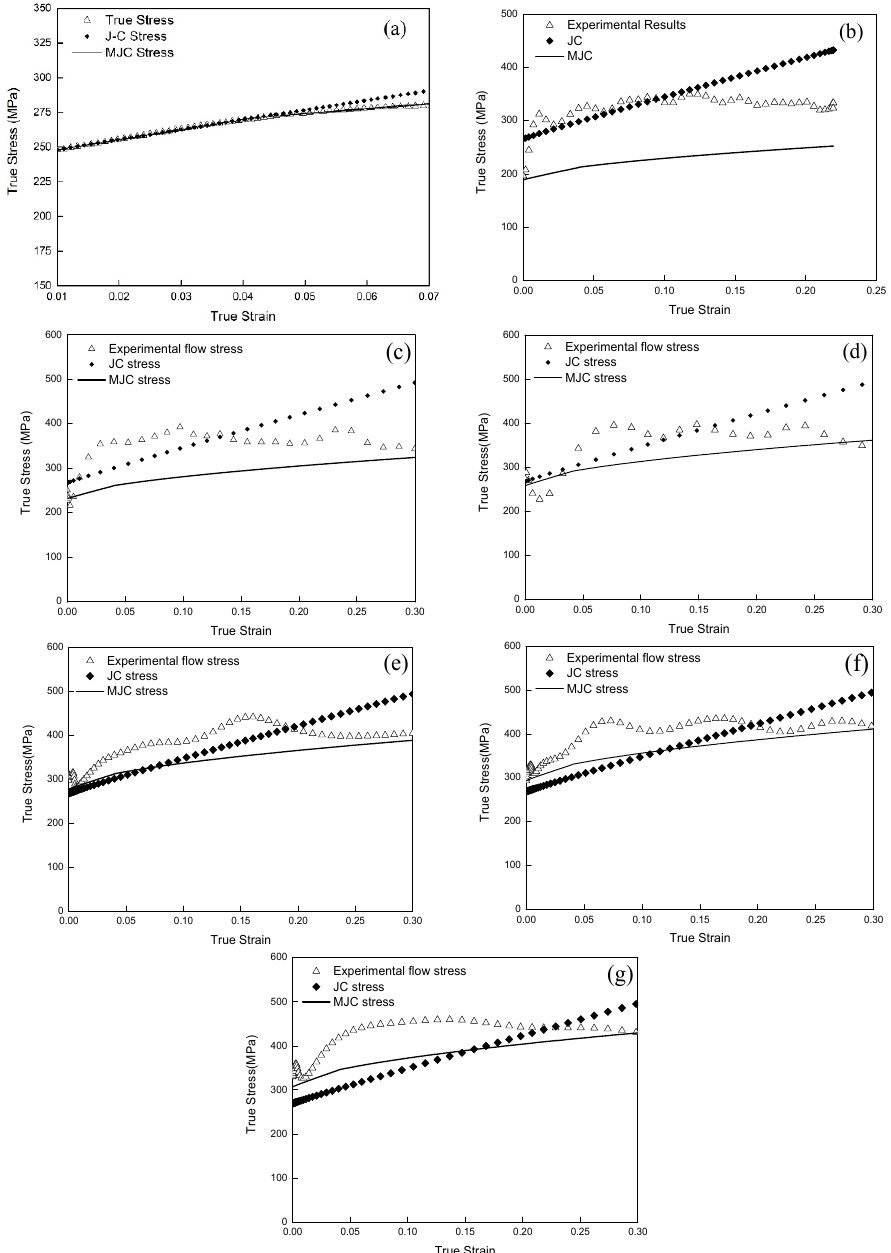
Figure 7. Comparison between experimental and predicted stresses at ( a ) reference strain rate; ( b ) 2000 s − 1 ; ( c ) 4000 s − 1 ; ( d ) 6000 s − 1 ; ( e ) 8000 s − 1 ; ( f ) 10,000 s − 1 ; ( g ) 12,000 s − 1 . From the above, the J–C constitutive model can only predict flow stress at lower strain rates. The accuracy of the improved J–C constitutive equation increased gradually with the increase of the strain